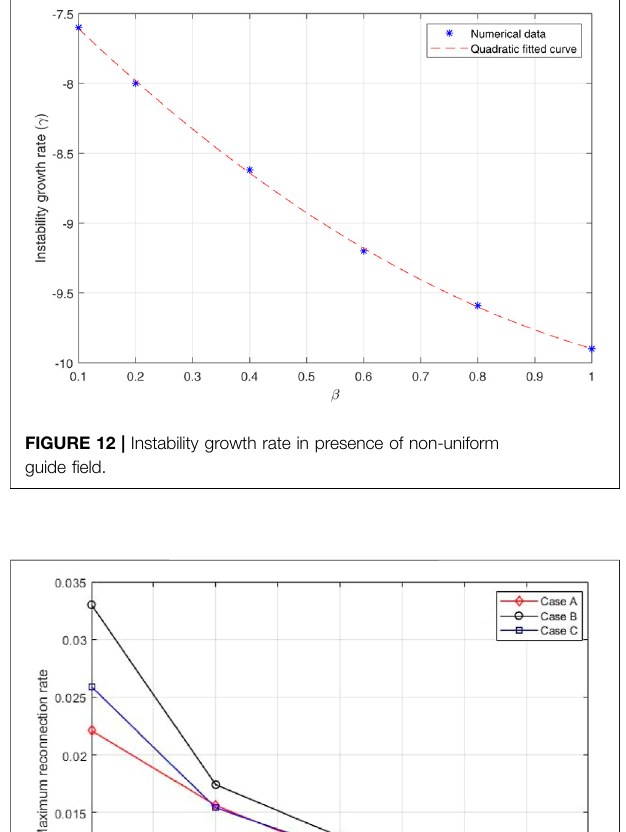
Frontiers in Astronomy and Space Sciences |